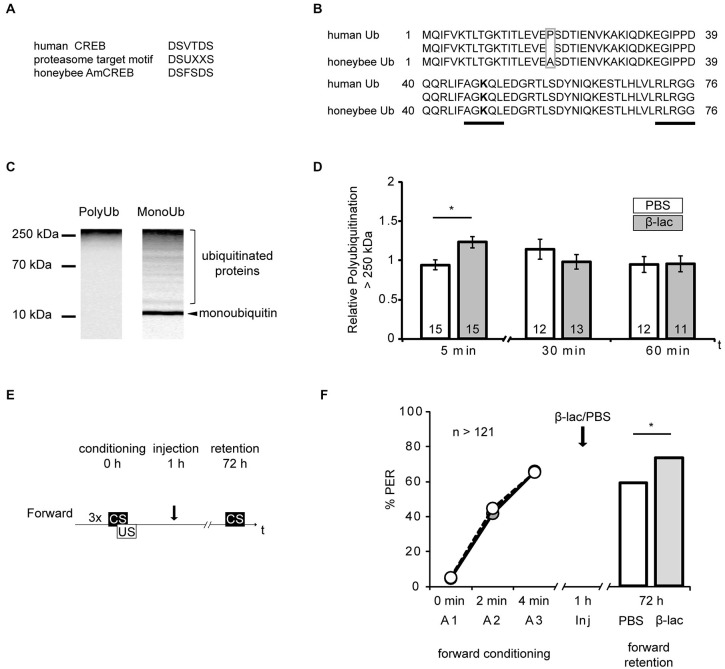
Proteasome inhibition by β-lactone enhances late long-term memories (lLTM) upon forward conditioning. (A) The proteasomal targeting motif of human CREB (Taylor et al., 2000) matches the amino acid sequence of AmCREB. (B) The comparison of the amino acid sequence of monoubiquitin derived from the human precursor UBC protein (Catic and Ploegh, 2005) compared to the predicted Apis mellifera ubiquitin revealed that these sequences are highly homologous. Only one out of 76 amino acids is different (gray box). The sequences that are critical for polyubiquitination (K48; bold, C-terminus) are identical (underlined in black). (C) Western blot analysis of mono- and poly-ubiquitin in bee brain lysate. A slot of a SDS-PAGE gel was loaded with bee brain homogenate. Following protein separation and blotting, the membrane was cut vertically from top to bottom in the middle of the lane and probed with antibodies detecting K48-linked poly-ubiquitin or mono-ubiquitin. The analysis shows that the monoubiquitin antibody detects a single band at ~10 kDa, whereas the antibody against K48-linked polyubiquitin does not detect this band. Both antibodies detect a smear. (D–F) Honeybees were injected with 1 mM of β-lactone (β-lac, gray) or the solvent PBS (white). The brains were dissected at 5 min, 30 min and 60 min after injection. (D) In order to examine the level of polyubiquitination, the membranes were cut into two on the level of the 70 kDa marker band. The upper part was probed with the antibody detecting K48-linked poly-ubiquitin and the lower part with the anti-α-tubulin antibody. Quantification shows that the signal is increased 5 min after injection in the β-lac groups compared to the PBS control group. (E) Honeybees were conditioned with three forward trials or three backward trials. One hour after conditioning, the honeybees were injected with either 1 mM of β-lactone (β-lac) or with the solvent PBS. Three days after conditioning, their memory was tested with one CS only trial. (F) The performance during the three forward conditioning trials did not differ in the bees subjected to the injection one hour later (arrow). Forward trained animals injected with β-lac (light gray) show increased performance during the memory test at 72 h after conditioning compared to the PBS control group (white). The asterisk indicates significant differences (p < 0.05).